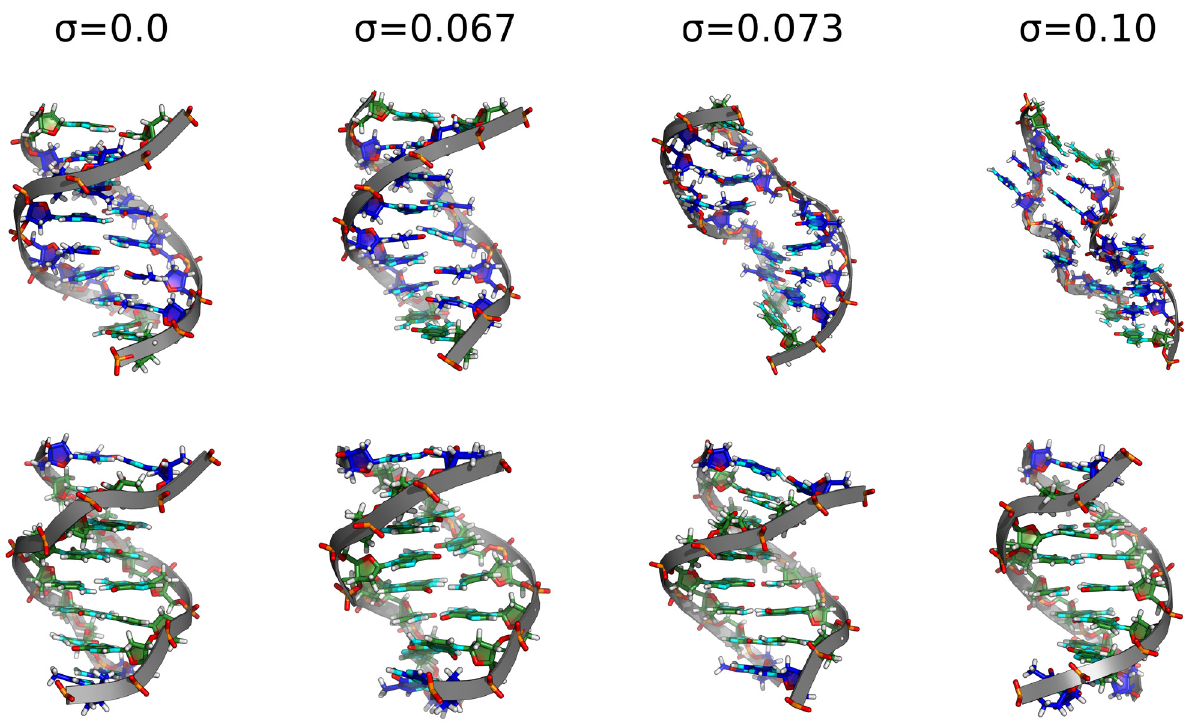
Fig 4. Snapshots of two selected 8 bp segments of the DNA at different levels of global unwinding (gc-sequence). Structures of the TATA- box containing segment are shown in the upper series. In the lower panels structures of a distant GC-rich segment are illustrated (same color-coding as in Fig